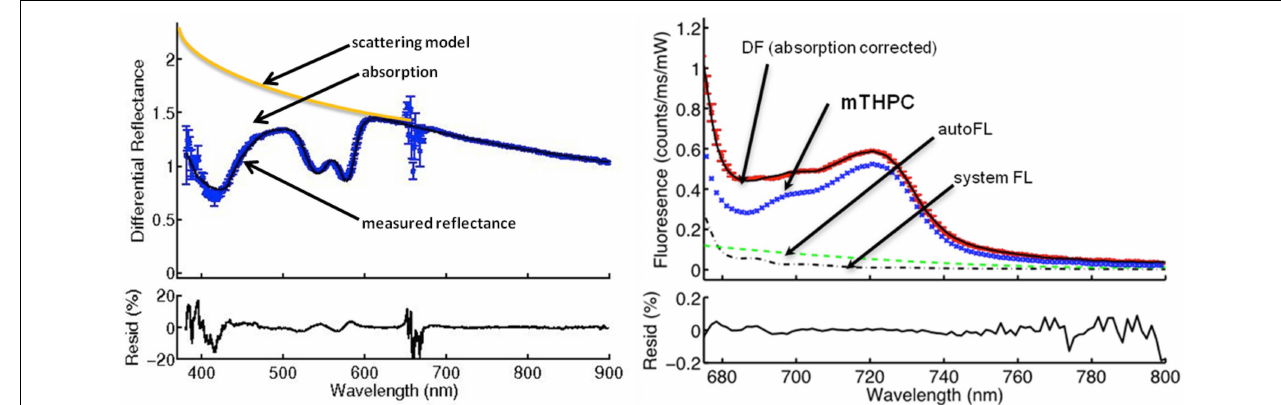
FIGURE 2 | The DPS (left) and FDPS (right) spectra from a center of the tumor before PDT. The absorption of light by the tissue as seen by the difference between the scattering model and the measured reflectance (DR) is used to calculate oxygen saturation, blood volume fraction, and vessel diameter and to correct the measured fluorescence for absorption. The noise at around 652nm is due to the notch filter. The components of the measured fluorescence (DF) are